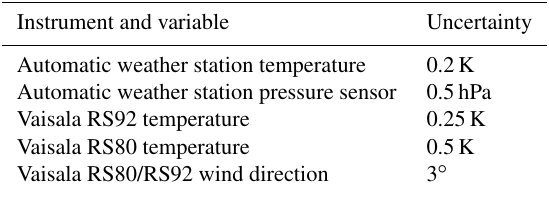
Table 3. Estimates of uncertainties associated with the measure- ments used in the